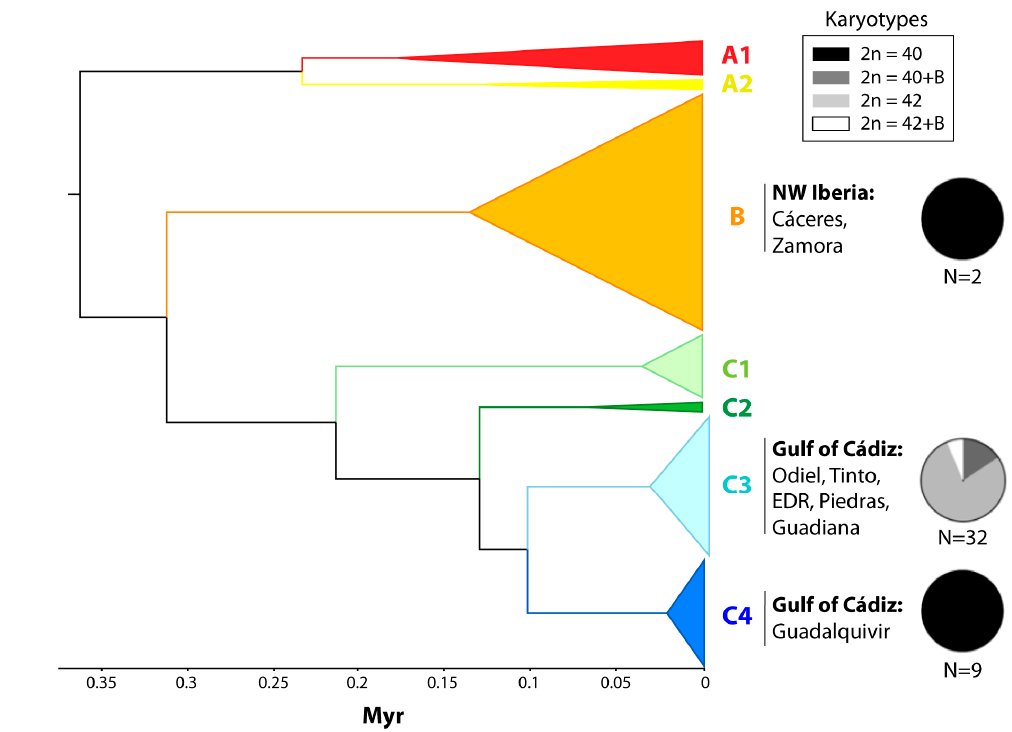
Figure 3. Distribution of karyotypes across the mitochondrial lineages described in Biedma et al. (2019). The geographical distribution of the sub-lineages sampled in this study is indicated. Pie charts represent the frequencies of karyotypes in each mitochondrial lineage, with N referring to the number of individuals sampled.